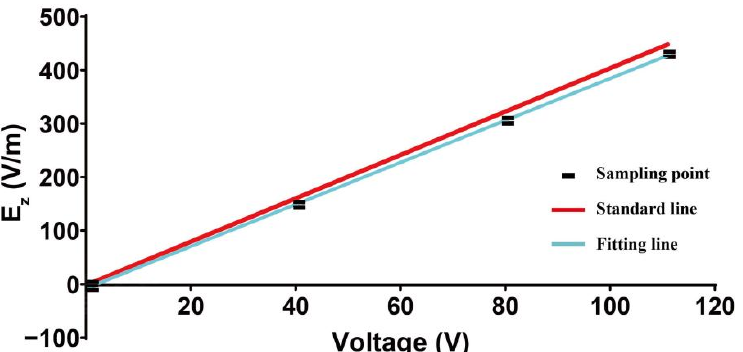
Figure 2. Results of the laboratory experiments (black squares indicate the sampling points obtained; the red line and blue line represent the standard curve and fitting curve, respectively).